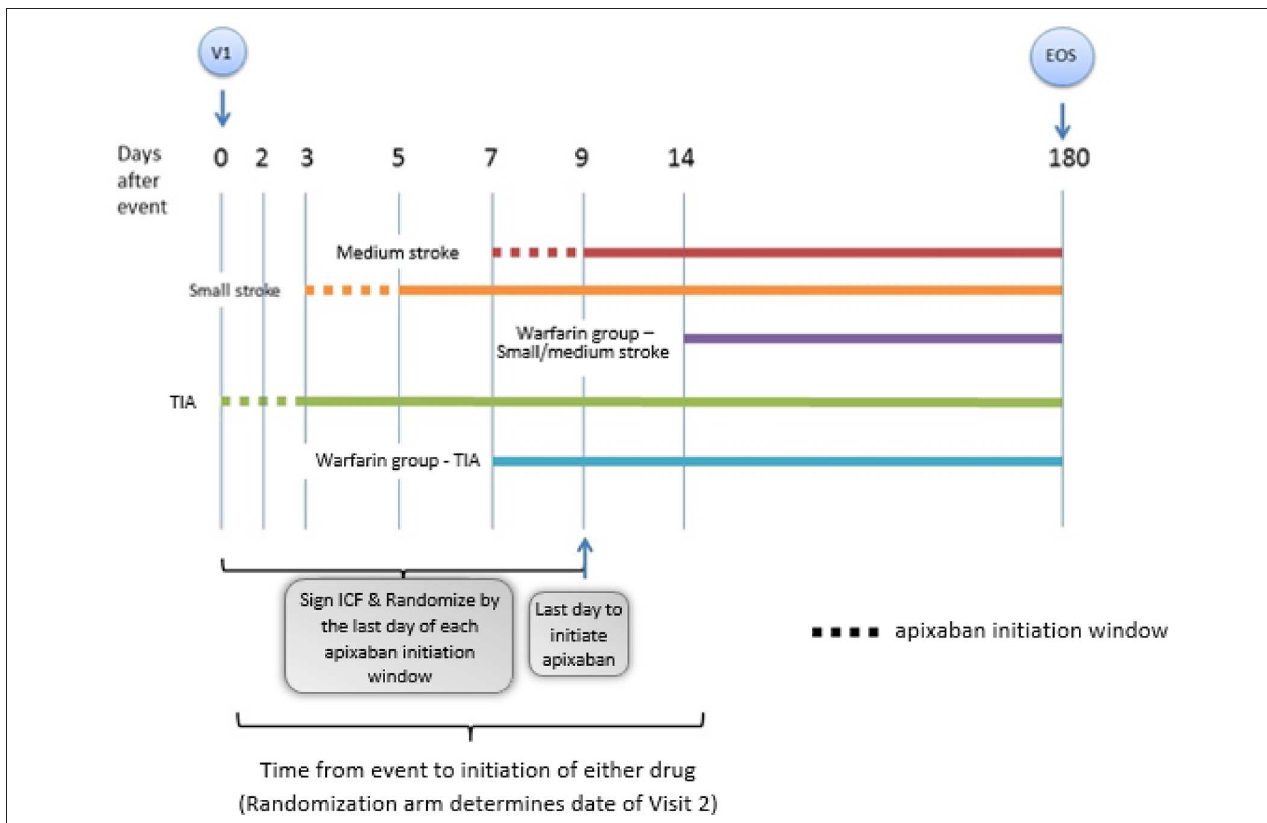
FIGURE 1 | This is a representation of the general study schema for the AREST (Apixaban for Early Prevention of Recurrent Embolic Stroke and Hemorrhagic Transformation) study (V1 = visit 1, time 0; EOS = end of study, day 180). Details of the follow up visits entailed in the follow up section of the proof of